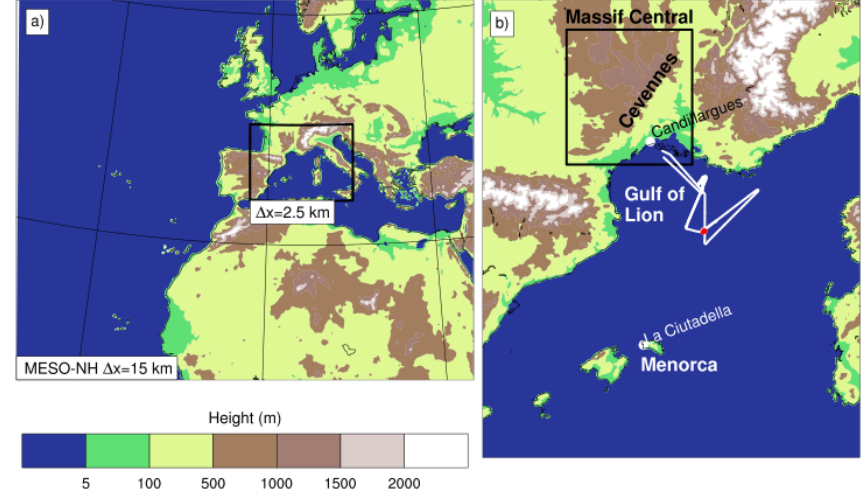
Figure 1. (a) Domains of nested Meso-NH simulations with overlaid orography. The grid size of the large domain is 15km while the grid size of the nested domain is 2.5km. (b) Nested domain with indications of the main orographic features as well as location of instruments used in this study. The thick white line is the ATR 42 flight track on 18 October 2012 while the red dot represents the location of the aircraft sounding during which remote sensing and in situ data used in this paper were acquired. The black box defines the Cévennes–Vivarais target area (2–5 ◦ E, 43.2–45.5 ◦ N), as defined for the HyMeX SOP